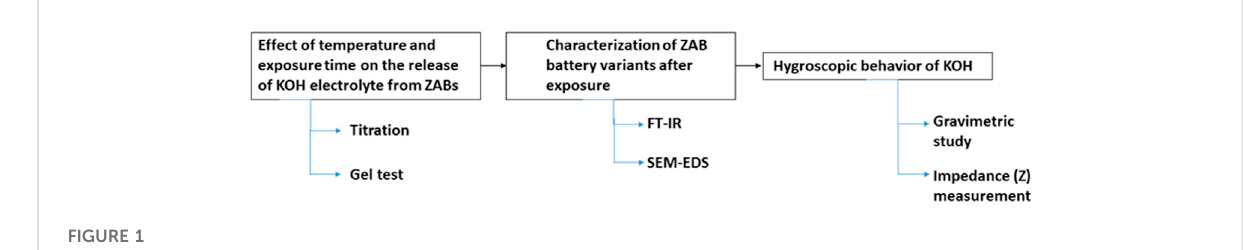
Flowchart explaining the sequence of testing